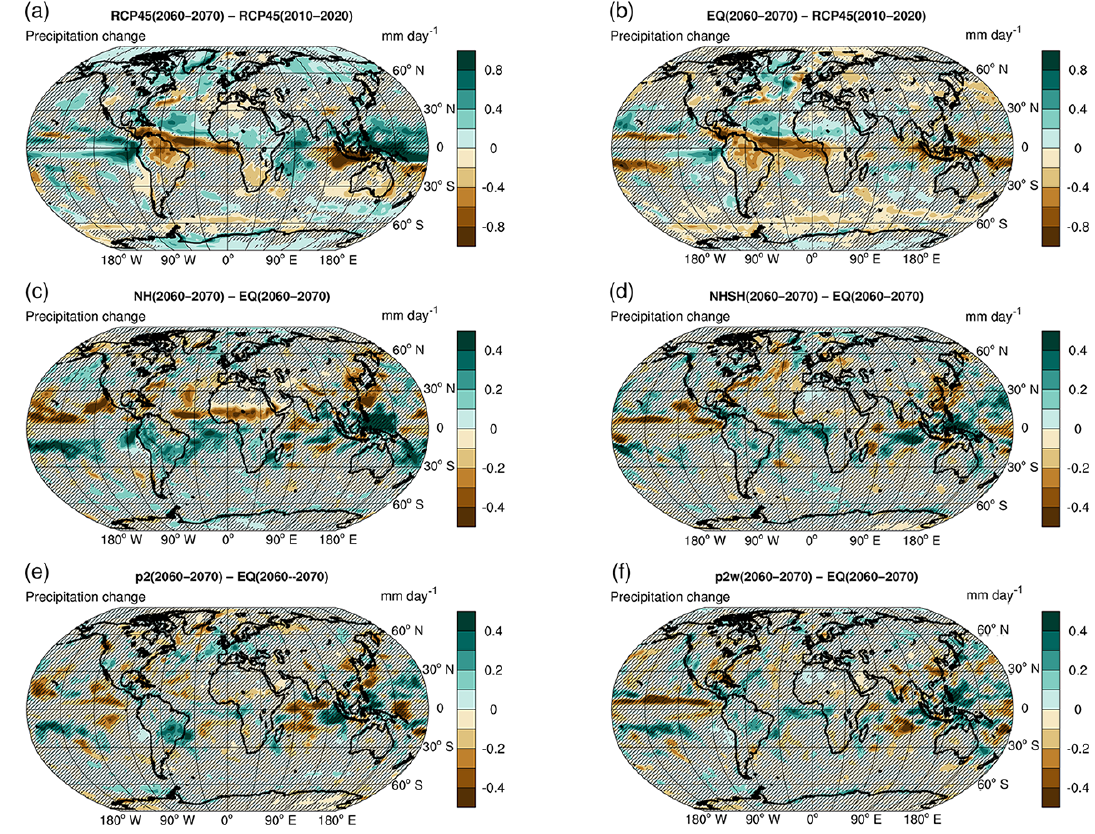
Figure 11. The precipitation anomalies for (a) RCP45, (b) EQ, (c) NH, (d) NHSH, (e) p2 and (f) p2w. Anomalies in (a, b) are presented as the differences between years 2060–2070 and 2010–2020. Anomalies in (c, d, e, f) are presented as the difference to EQ between years 2060–2070. The hatching indicates regions where the change of precipitation is not statistically significant at 95%